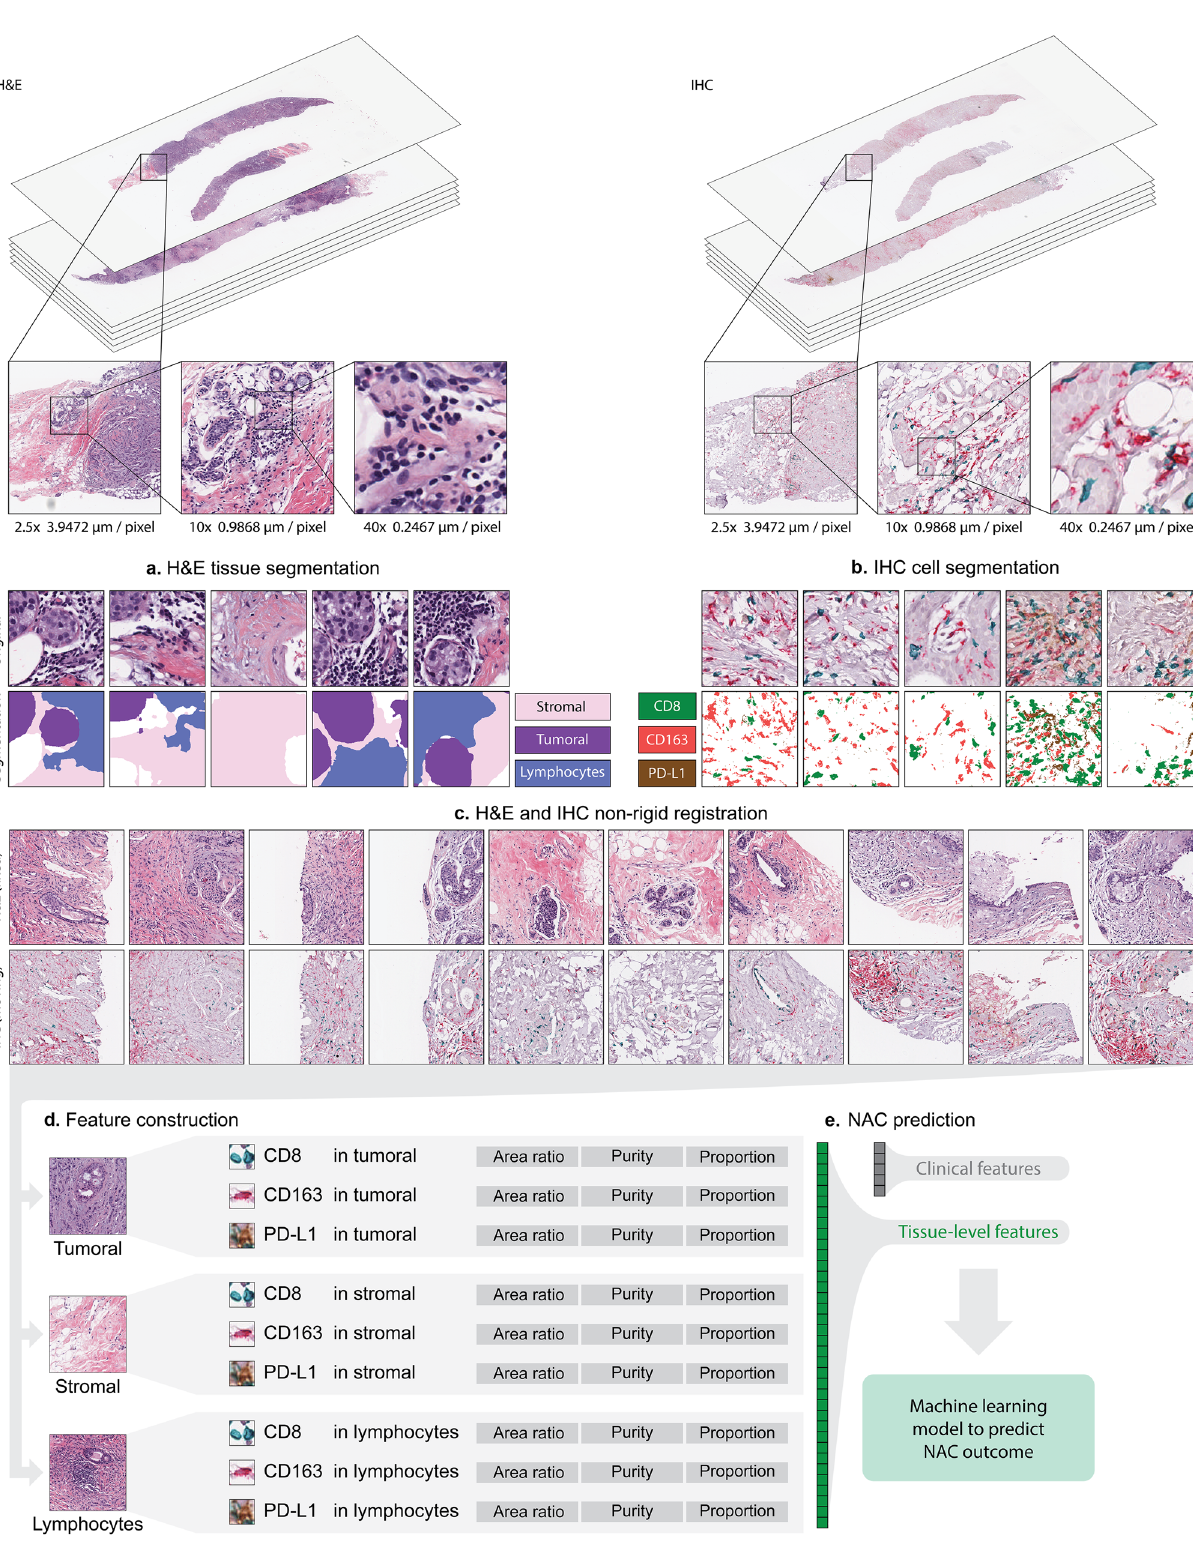
Fig. 1 Overview of our work fl ow. a H&E tissue segmentation based on DeepLabV3 model. The segmentation generates stroma region, tumor region, and lymphocytes aggregated (lymph) region. b IHC markers segmentation. CD8, CD163, and PD-L1 were segmented. c H&E and IHC non-rigid registration. First row: representative H&E patches; second row: corresponding IHC patches after registration. d IMage-based Pathological REgistration and Segmentation Statistics (IMPRESS) feature construction. Totally 36 IMPRESS features were constructed. e Neoadjuvant chemotherapy (NAC) prediction with logistic